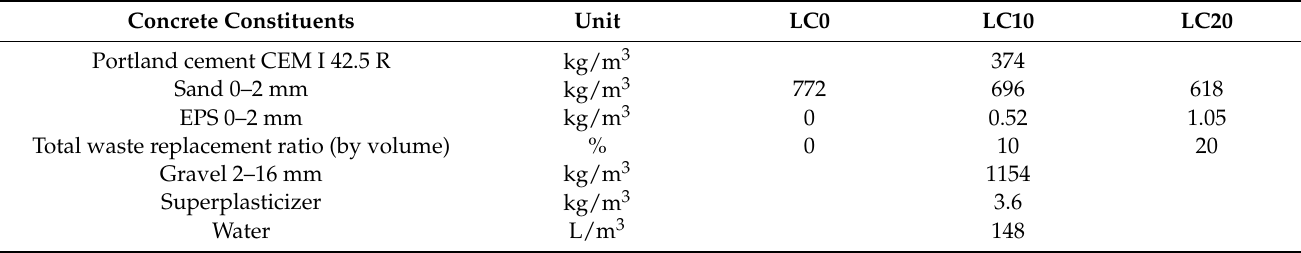
Table 5. Composition of concretes without/with recycled